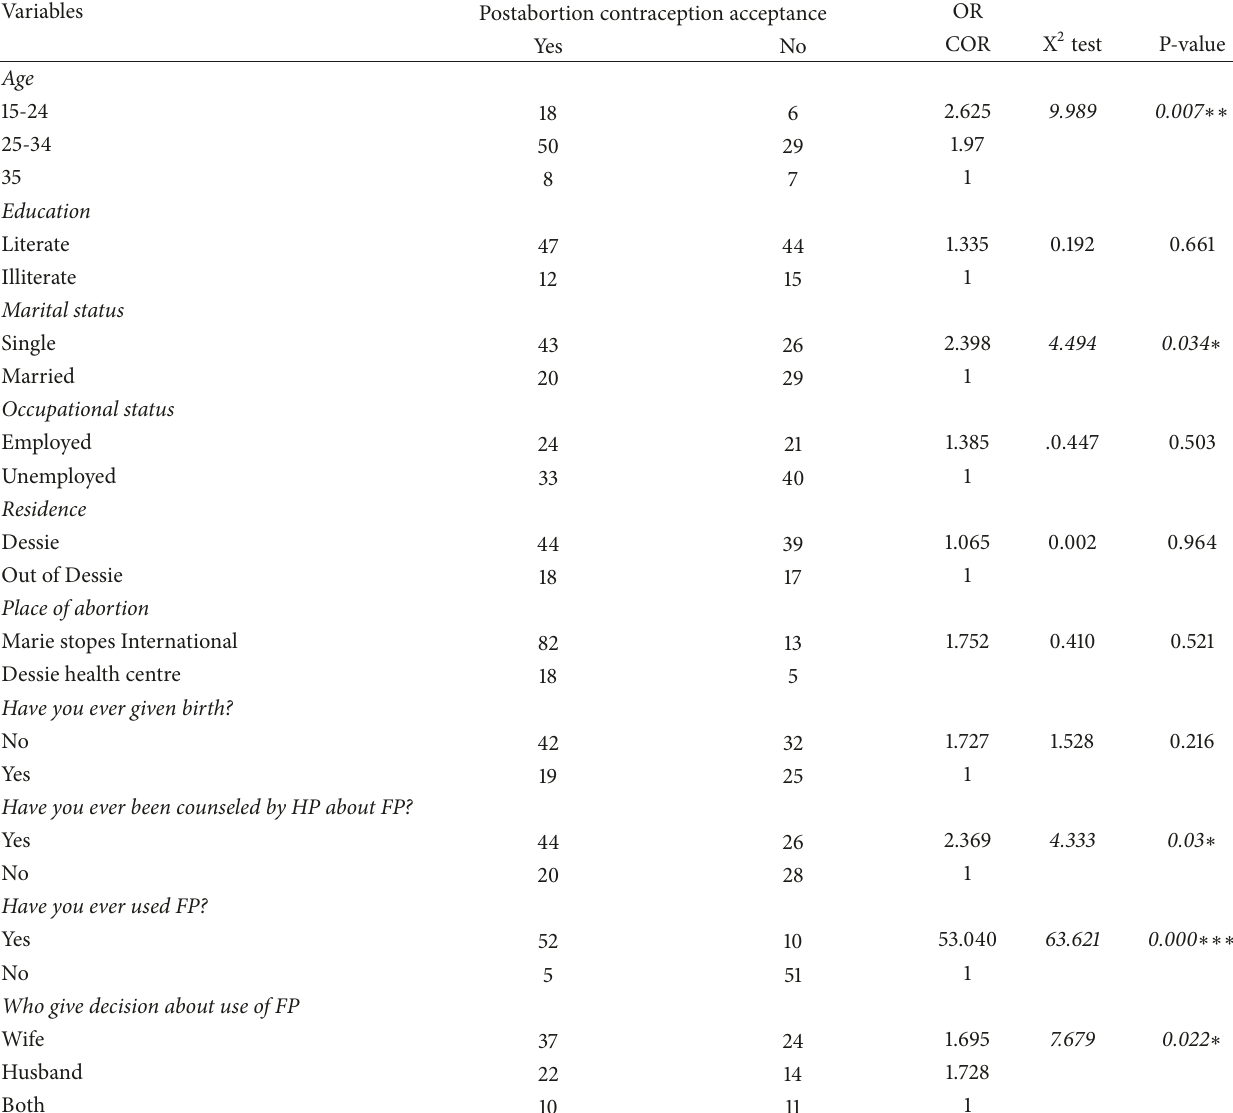
Table 4: Factors associated with Postabortion contraception acceptance among abortion service clients in Dessie, Amhara, Ethiopia,